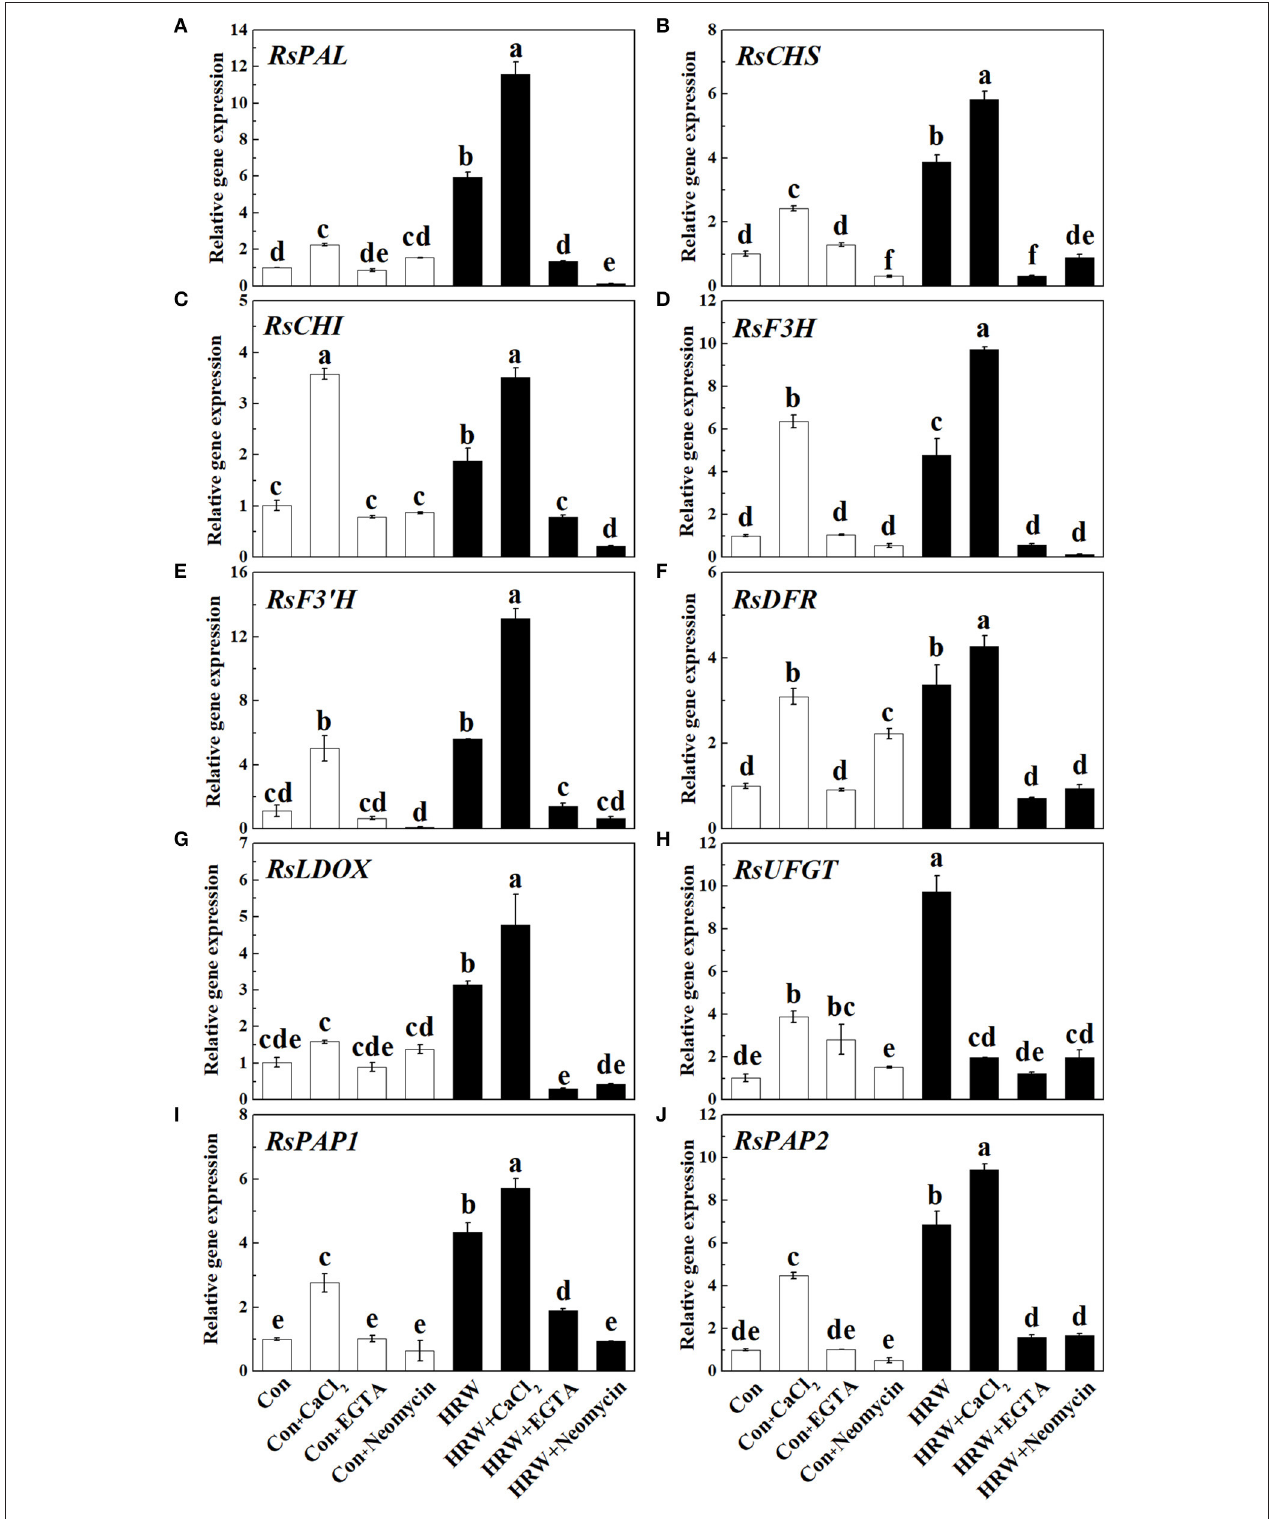
FIGURE 5 | Expression of genes related to anthocyanin biosynthesis in radish sprouts hypocotyls under UV-A irradiation. Radish sprouts were further incubated in distilled water or HRW (100% saturation) containing 10mM CaCl 2 , 1mM EGTA or 1mM Neomycin. The sample with distilled water alone was the control (Con). The gene expression levels of RsPAL (A) , RsCHS (B) , RsCHI (C) , RsF3H (D) , RsF3’H (E) , RsDFR (F) , RsLDOX (G) , RsUFGT (H) , RsPAP1 (I) and RsPAP2 (J) were analyzed by qRT-PCR at 12h plant growth under UV-A. Data are presented as means ± SE ( n = 3). Bars with different letters are significantly different at P < 0.05 according to Duncan’s multiple